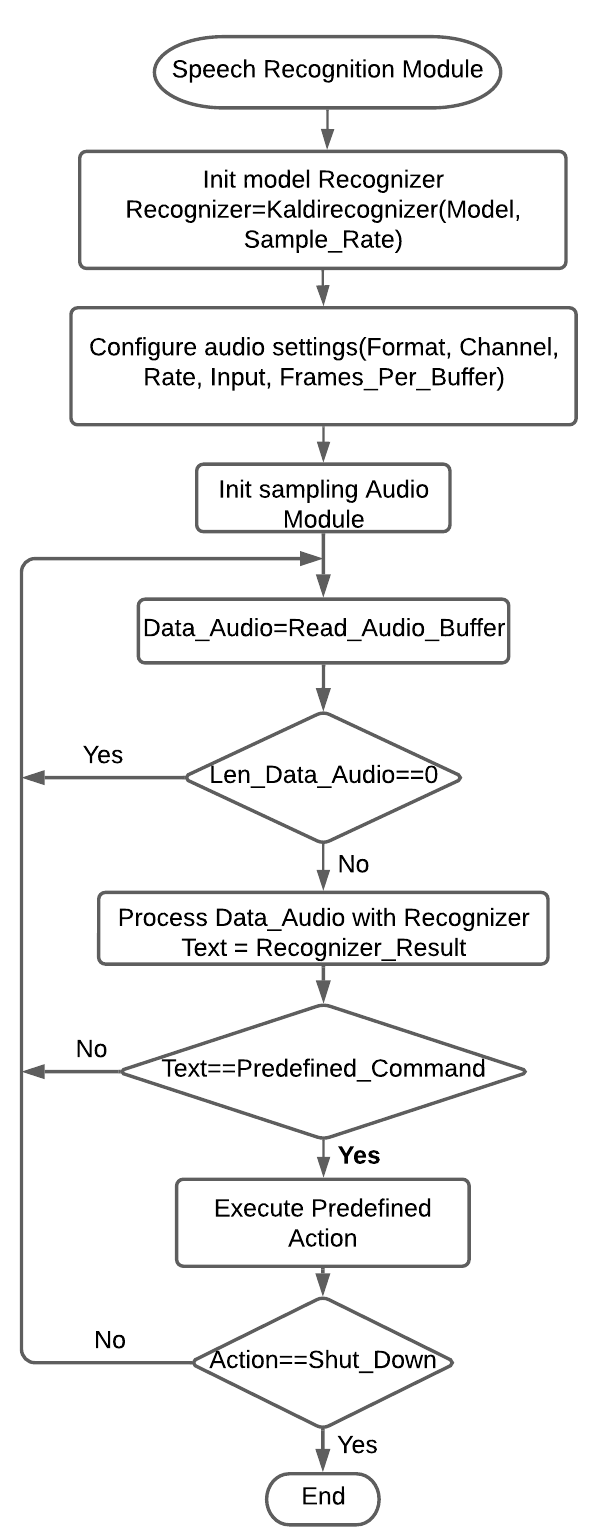
Figure 6. General flowchart of speech recognition module. Note: the parameter values are MODEL = Spanish, Sample Rate = 16 k, Format = 16 Bits, Channel = 1, Rate = 16 k, Input = True, and Frames_Per_Buffer =